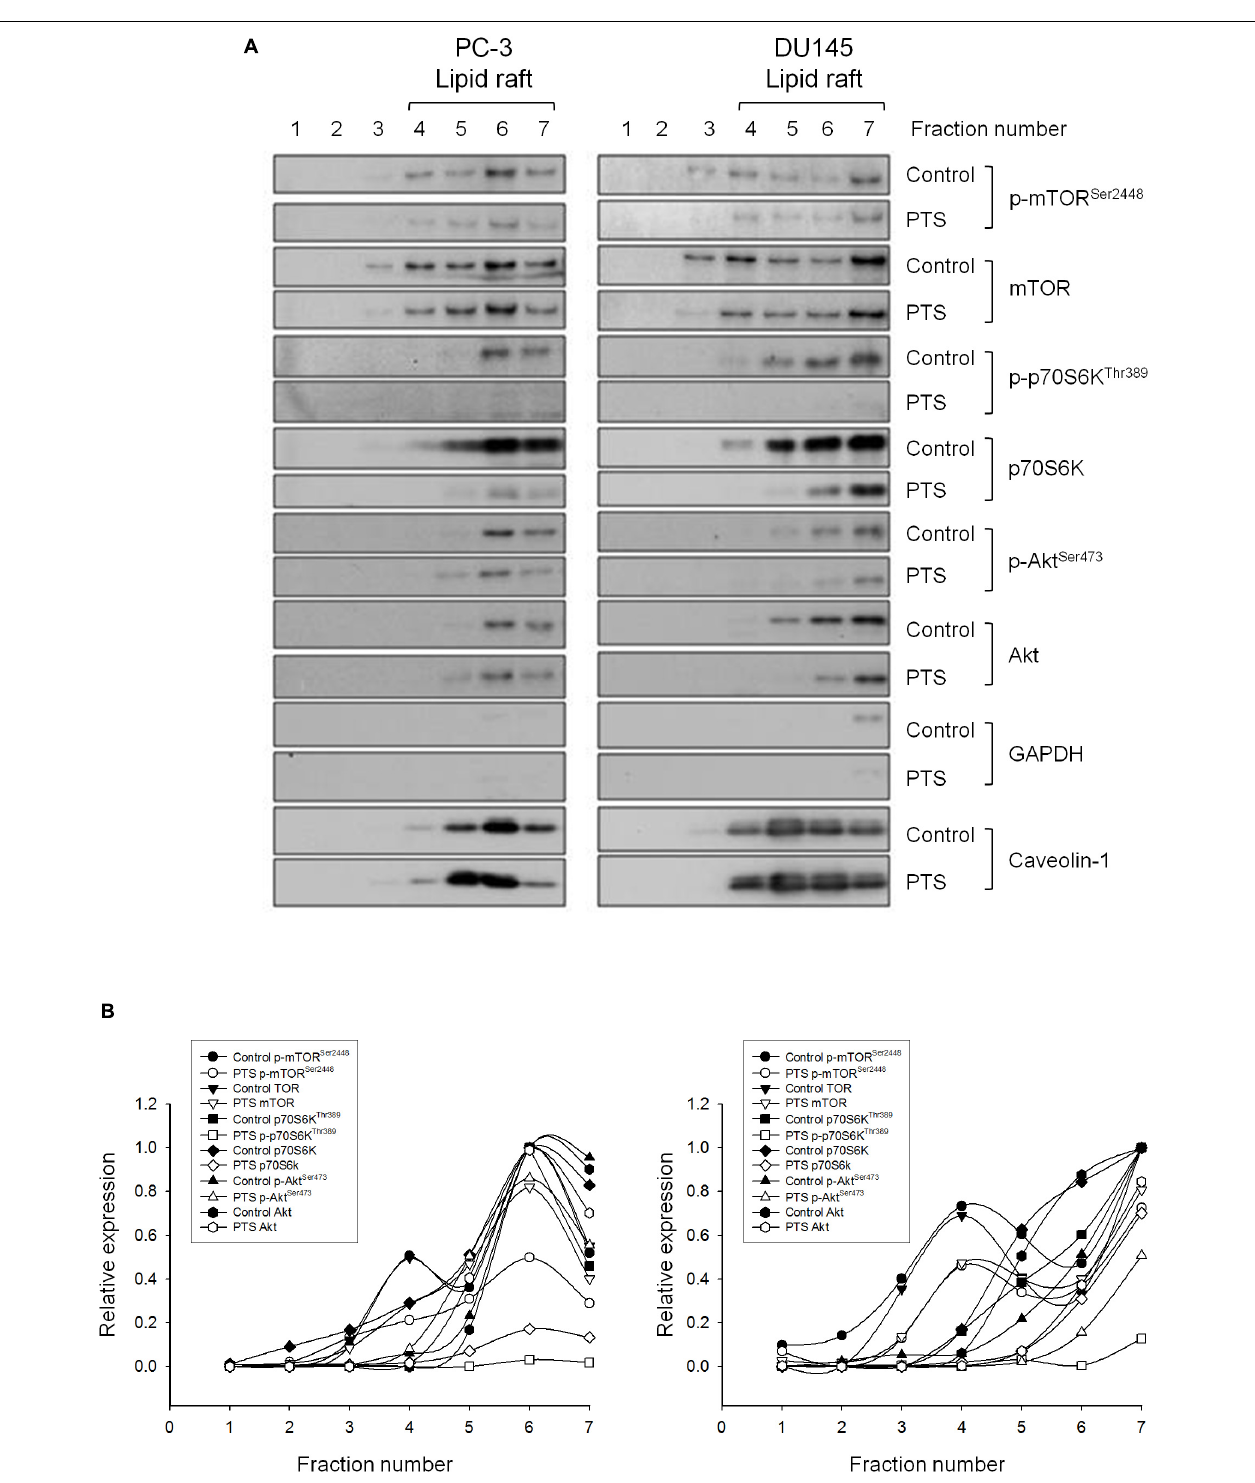
FIGURE 5 | Effect of PTS on lipid raft-associated expressions of several kinases. (A) PC-3 and DU-145 cells were incubated in the absence or presence of 6 mM PTS for 2 h. After treatment, the cells were lysed in 1% Triton X-100 and fractionated by centrifugation as described in Section “Materials and Methods.” The protein expressions were detected by Western blotting. (B) The expressions were quantified using Image Lab Software 6.0 (BIO-RAD).